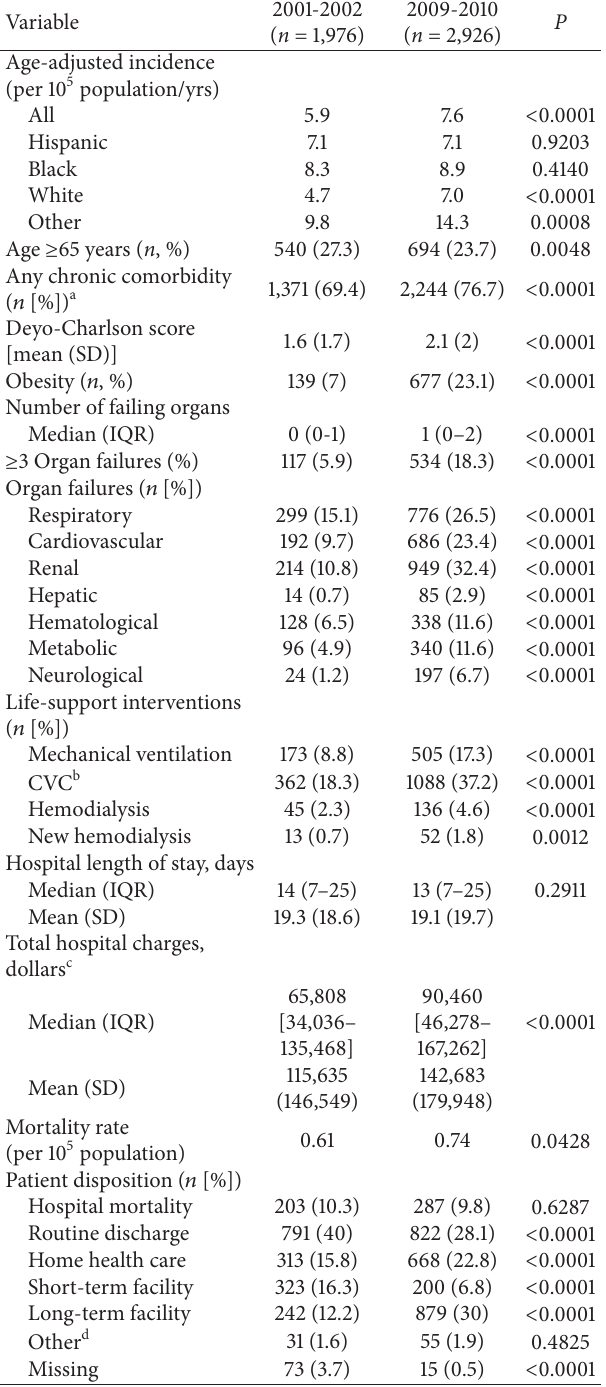
Table 2: Changes in the epidemiology, patient characteristics, resource utilization, and outcomes of NF